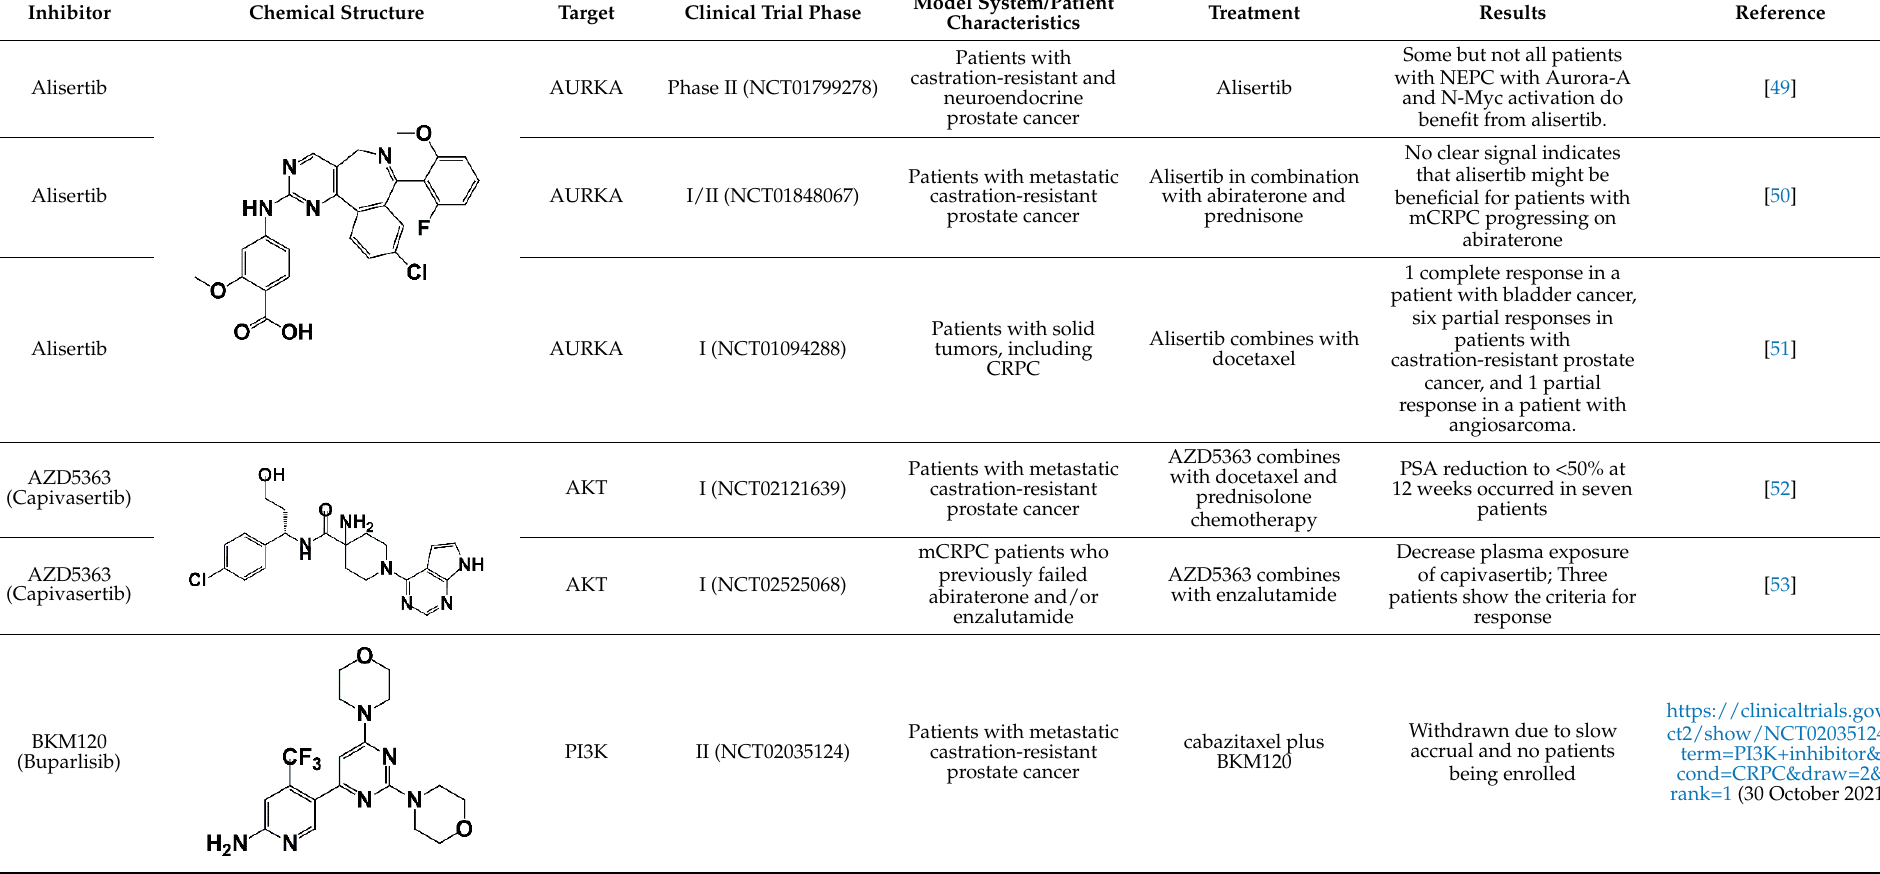
Table 2. Kinase inhibitors for CRPC in clinical